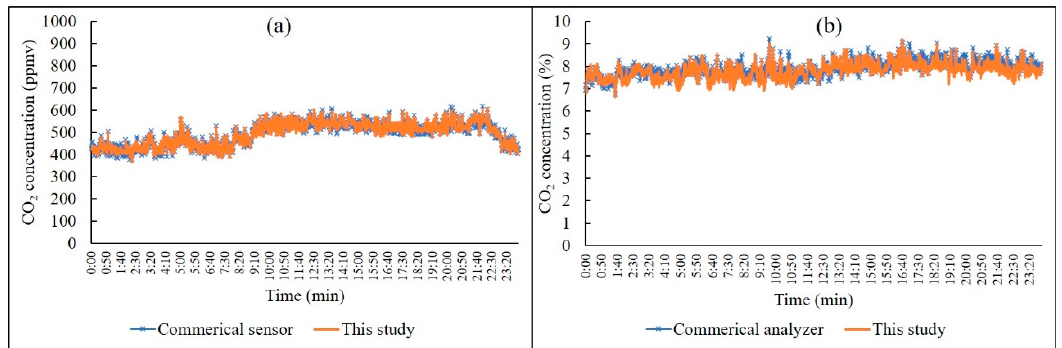
Figure 10. A comparison between the analyzer used in this study and a commercial device. Comparison at the ppmv level ( a ) and comparison at the percentage level ( b ).